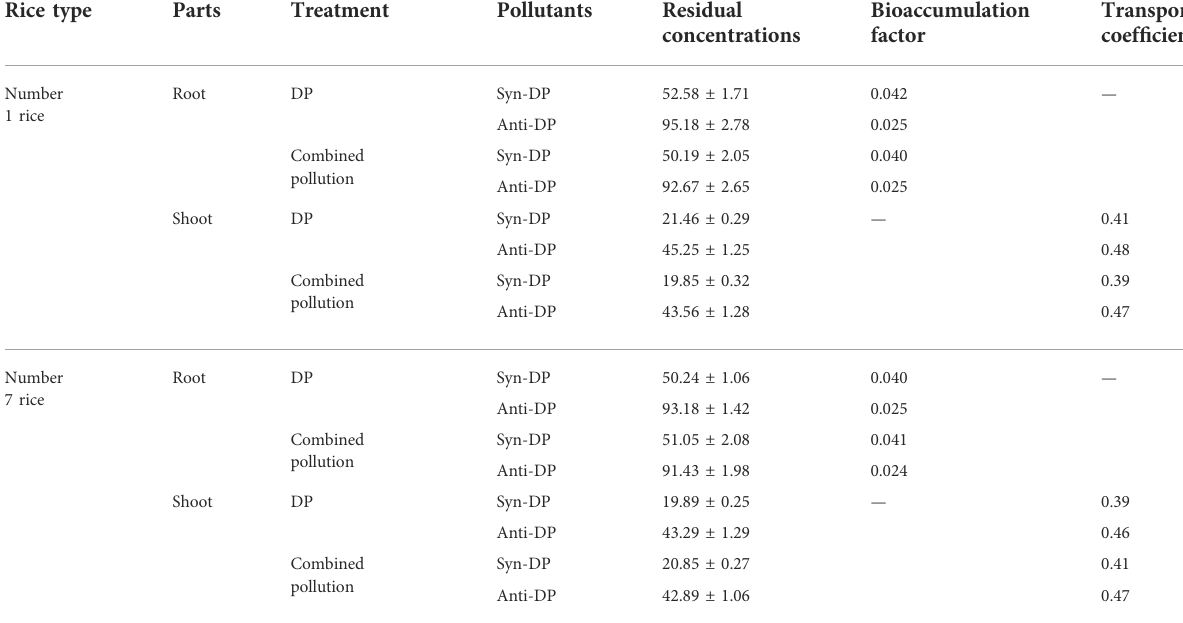
TABLE 2 Bioaccumulation and biological transport of DP in rice